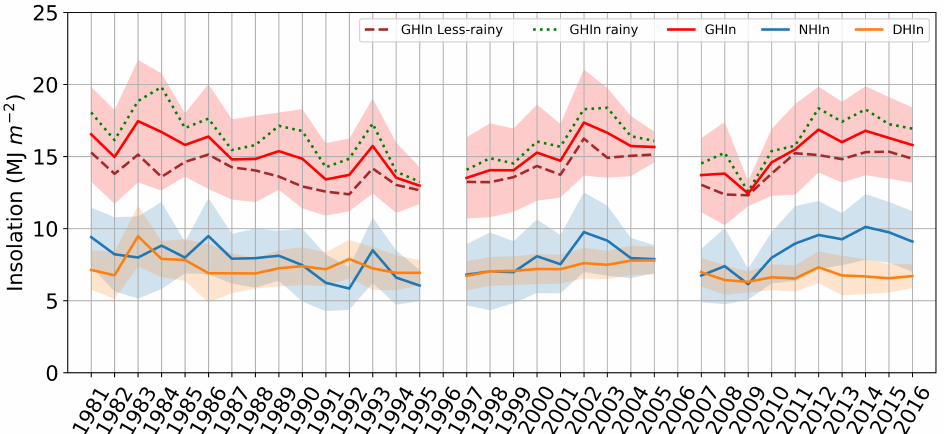
Figure 8. Annual averages of global (GHIn), diffuse (DHIn) and direct (NHIn) horizontal solar insolation for the 1981–2016 period. Shaded areas correspond to standard deviation. GHIn is also represented for rainy period (dotted green line) and less rainy period (dashed brown